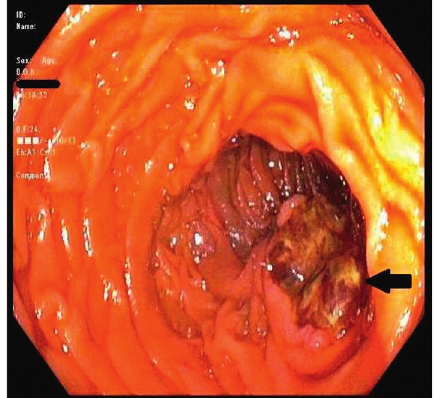
Figure 1: Arrow pointing at a friable ulcerated mass in the third portion of the duodenum.